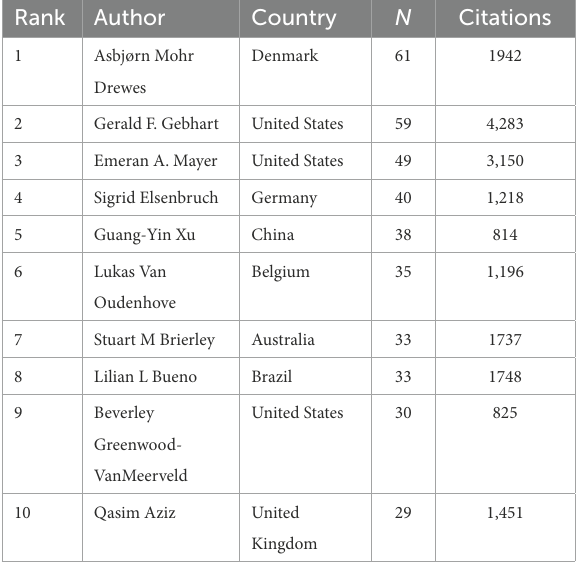
TABLE 1 The top 10 productive